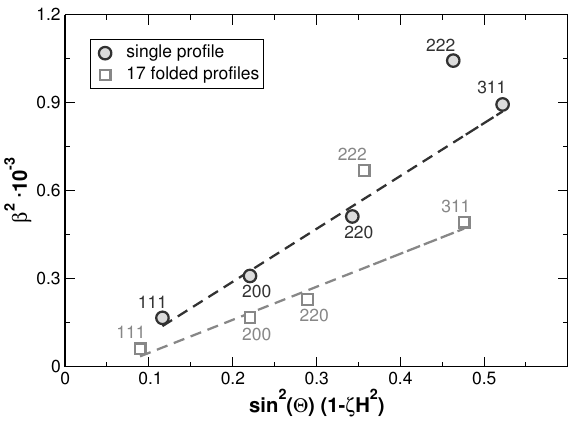
Figure 9. Williamson-Hall analysis of the present results. An alternative presentation of the results, that emphasizes the elastic anisotropy, can be found in Appendix